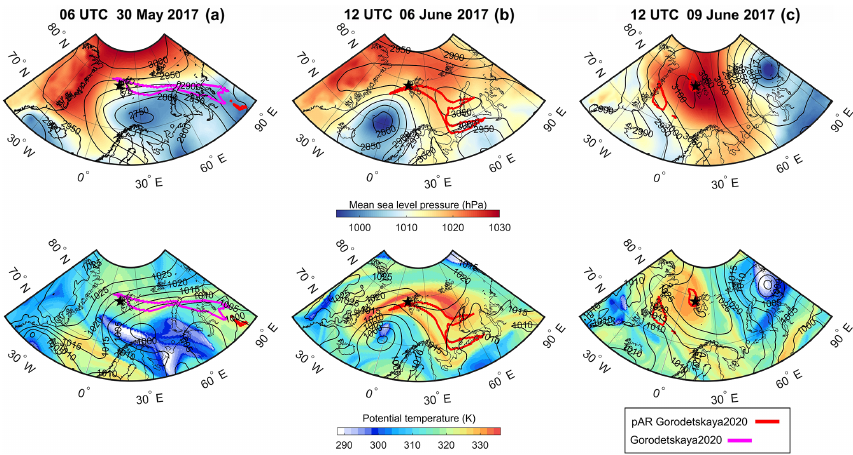
Figure 4. Maps of mean sea level pressure (hPa, coloured shading) and geopotential height at 700hPa (m, contours) (top row) and maps of potential temperature at 2PVU (K, coloured shading) and mean sea level pressure (hPa, contours) (bottom row) based on ERA5 reanalysis during the peak of the 30 May event (a) , the 6 June event (b) , and the 9 June event (c) . The magenta line shows the AR shape (based on Gorodetskaya2020), and the red line shows the shape of pARs (IWV ≥ IWV thres , based on Gorodetskaya2020). The black star shows the Ny-Ålesund location. Figures S4 and S5 show the complete temporal evolution of the synoptic conditions during the events.